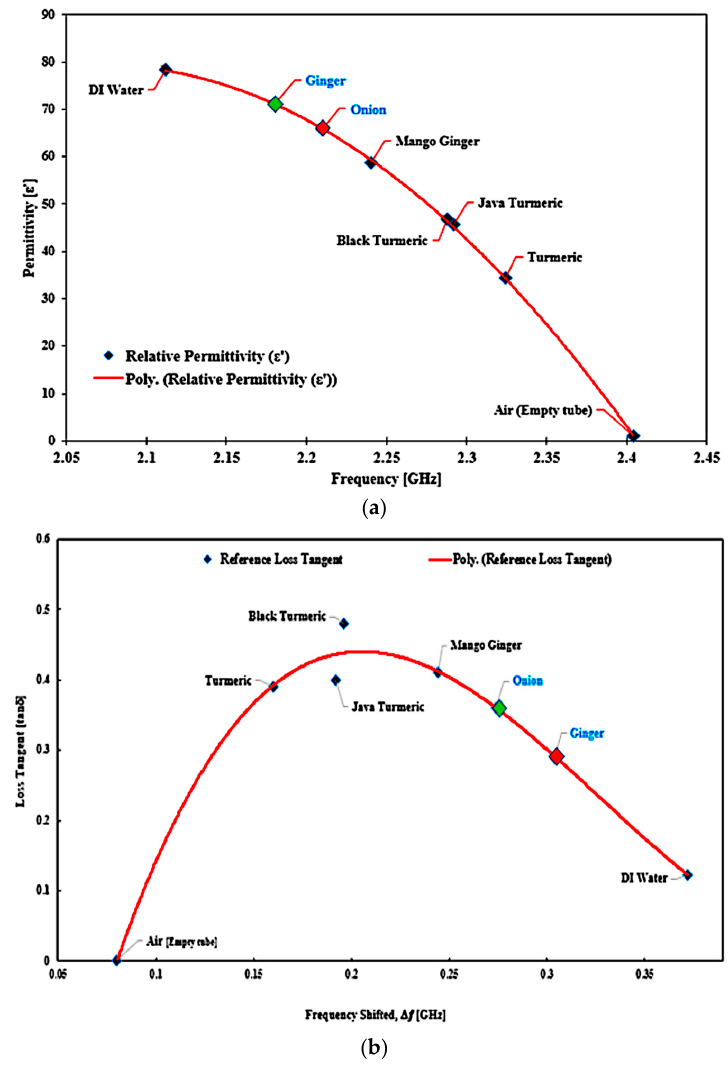
Figure 21. The position value of unknown SUTs (semi-solid) based on frequency and calculated ( a ) real permittivity and ( b ) loss